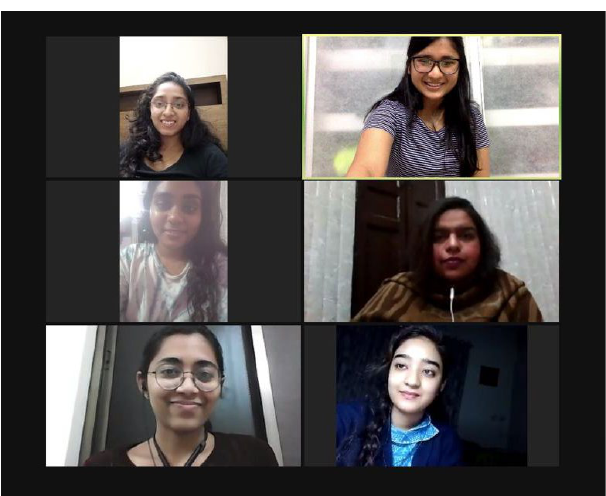
Figure 3 . Snapshot from a Zoom Meeting During a PRMP Informative